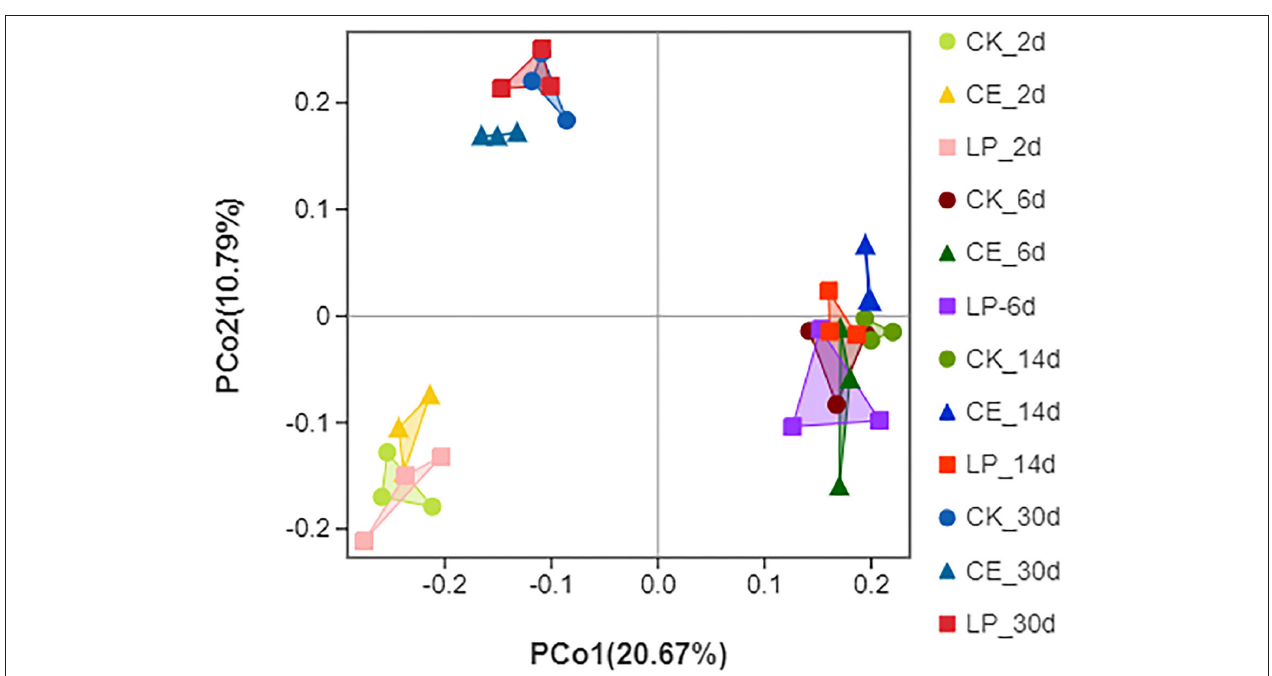
FIGURE 1 | Principal coordinates analysis (PCoA) of bacterial communities for cassia alata silage (CK, control; CE, cellulase; LP, Lactiplantibacillus plantarum , after 2, 6, 14, and 30 days of ensiling, respectively).